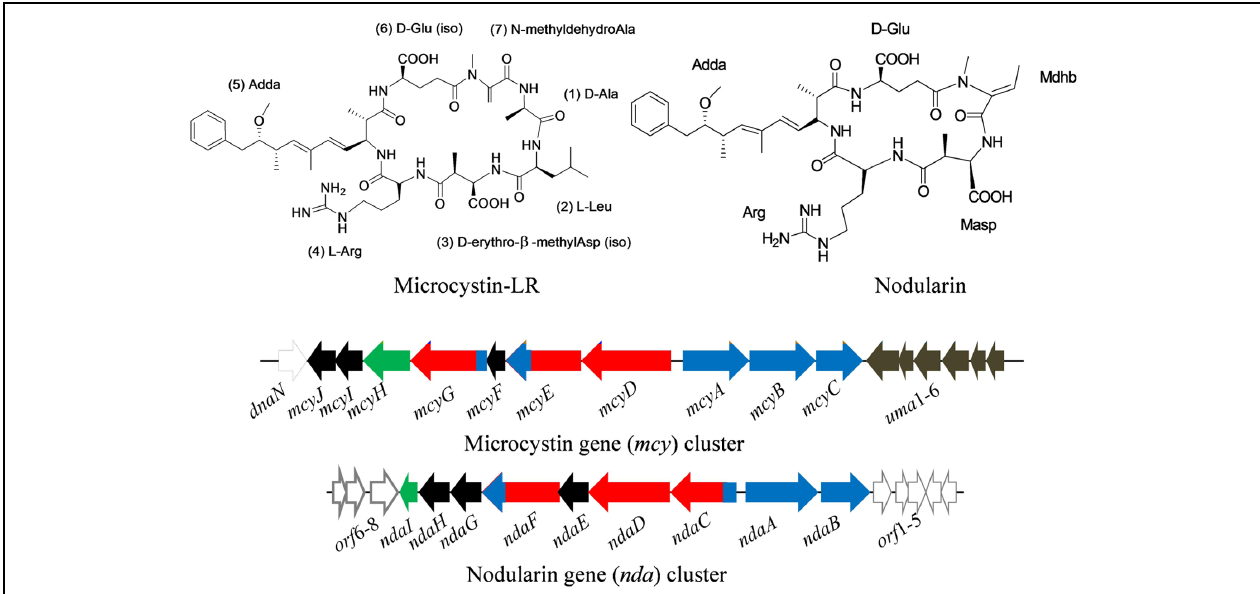
FIGURE 3 | Chemical structure of microcystin (MC-LR) and nodularin (NOD), and their biosynthetic gene clusters, mcy and nda in the cyanobacteria Microcystis aeruginosa PCC7806 and Nodularia spumigena NSOR10, respectively. Black – tailoring enzymes, red – polyketide synthases, blue – non-ribosomal peptide synthetases, light black – non-microcystin synthetase, green – ABC transporter (adapted from Tillett et al., 2000; Moffitt and Neilan, 2004; Gehringer et al., 2012; Gehringer and Wannicke, 2014; Gene cluster not drawn to